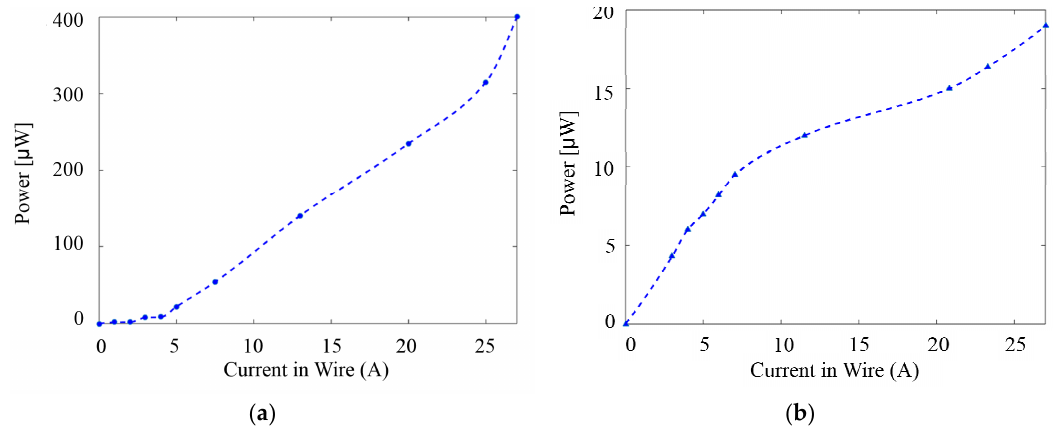
Figure 5. ( a ) Power output of EH1; ( b ) Power output of EH2. Measured RMS power output of two harvesters with regard to the current passing through the conducting wire. (The distance between EH1 and the wire is 6 mm and 4.5 mm for EH2 for a higher output power) EH2 has much lower output power than EH1 as a result of screen-printed PZT versus bulk PZT.